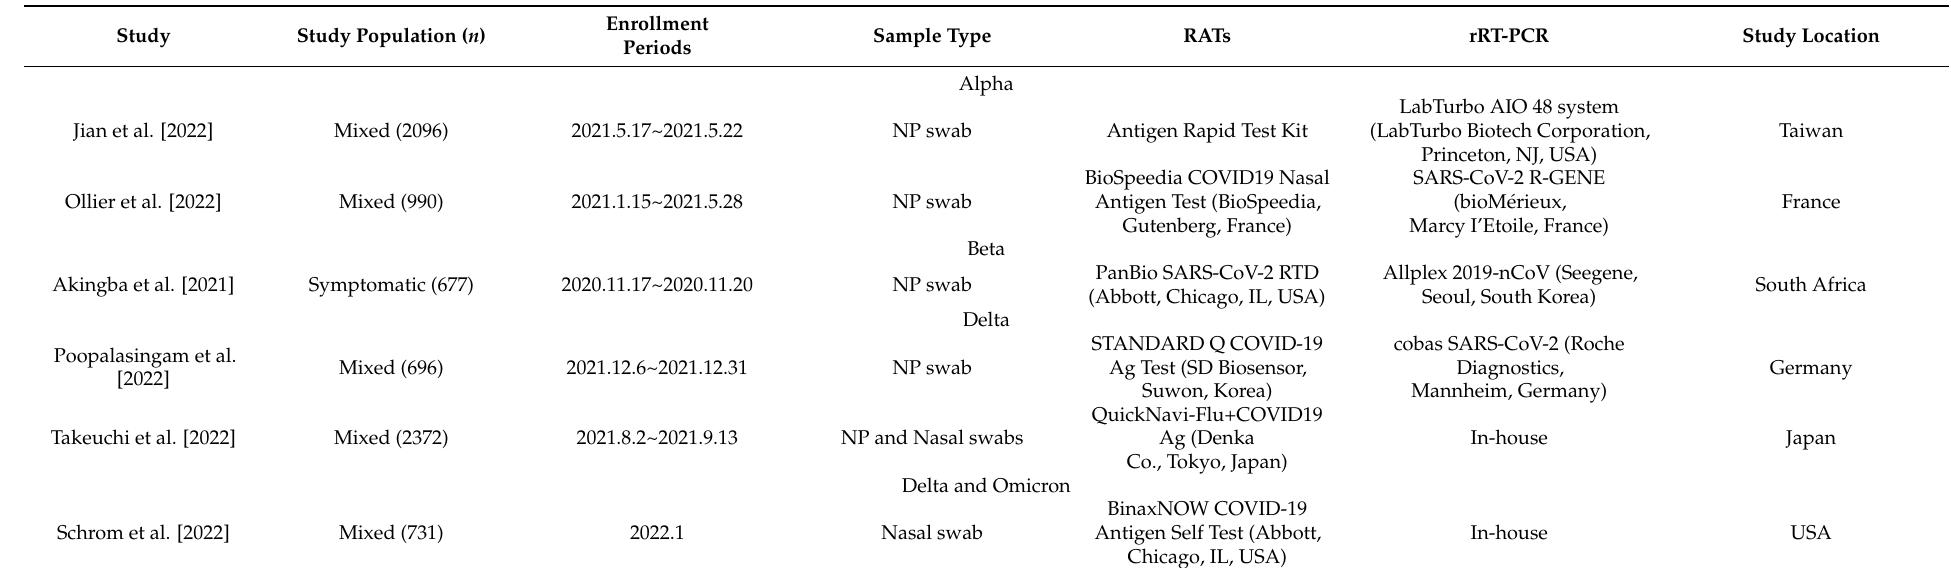
Table 1. Characteristics of included studies stratified by